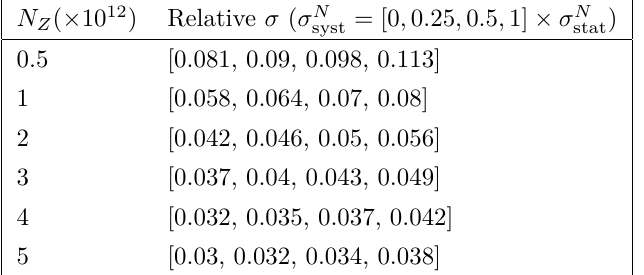
Table 4 . Estimated relative precision on R as a function of N Z , where four different levels of systematic uncertainty on the signal yield are shown.